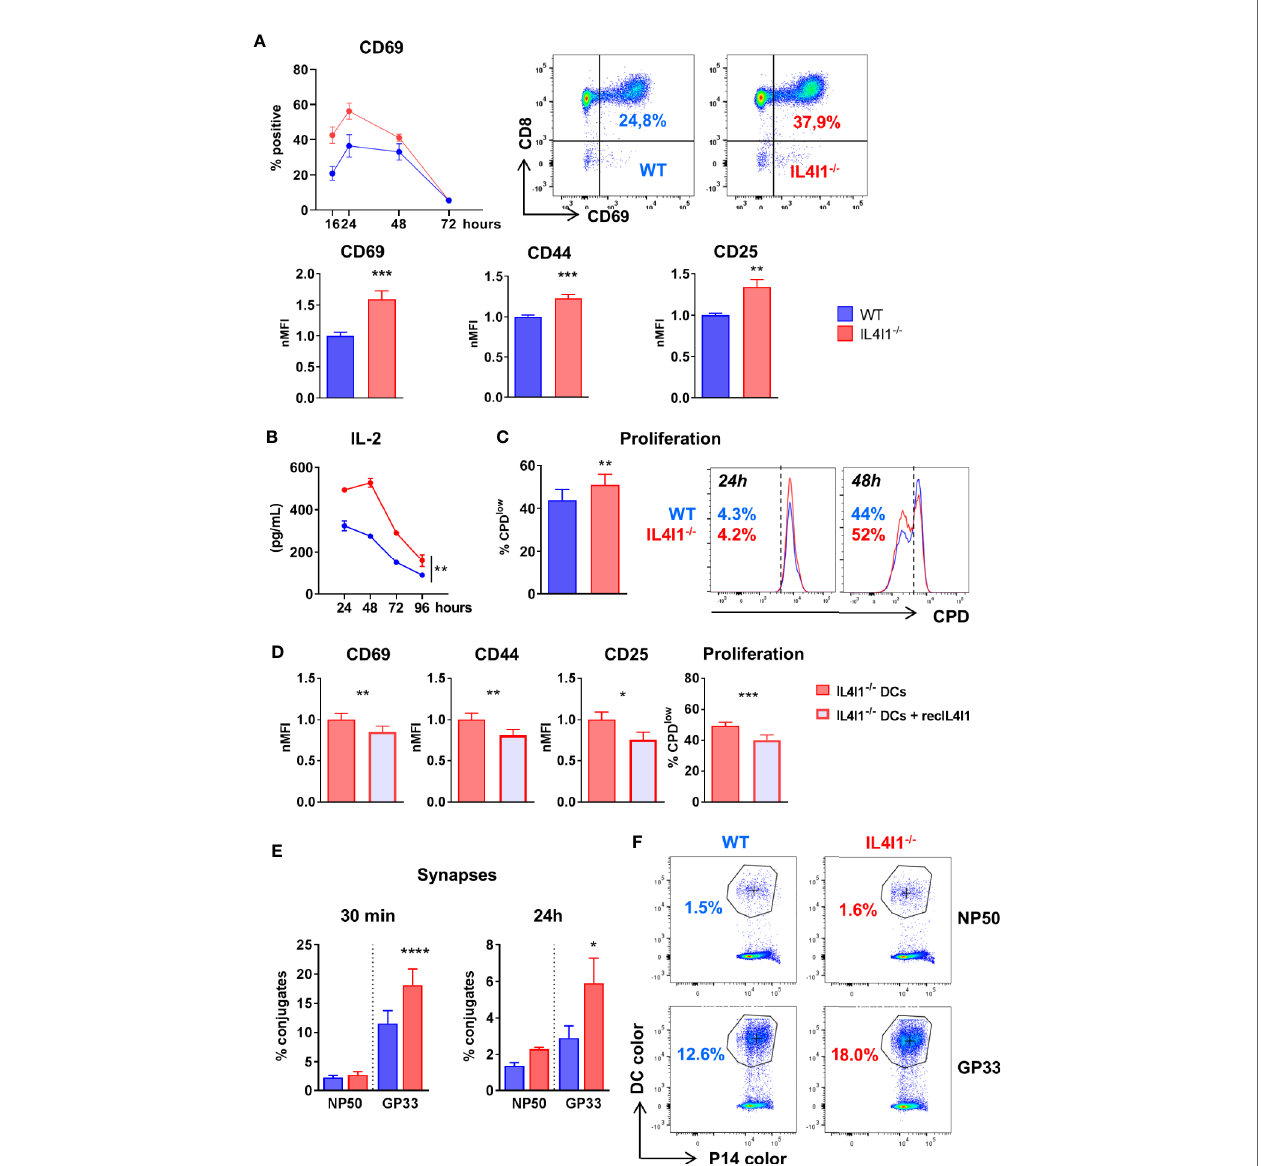
FIGURE 5 | Stronger in vitro activation of P14 cells by IL4I1 -/- DCs. DCs from WT (blue) and IL4I1 -/- (red) mice were sorted negatively, pulsed with the GP33 peptide, and plated with sorted P14 CD8 + T cells at a 1:10 ratio. (A) Expression of surface activation markers measured by fl ow cytometry on P14 cells. Top graph and dot-plots: kinetics of CD69 + P14 cells (left; mean ± SEM from one representative experiment, with two tests per condition using DCs sorted from independent mice) and representative data at 16 h (middle and right). Bottom histograms: the MFI of CD69, CD44, and CD25 at 24 h was normalized to the mean results in cocultures with WT DCs (nMFI). Mean ± SEM of values from a minimum of 12 tests per condition obtained in six to eight independent experiments. ** p < 0.005, *** p < 0.001 (Paired t-test). (B) Kinetics of IL-2 production in the cocultures from one representative experiment (n = 2 tests per condition). ** p < 0.005 (two-way ANOVA). (C) Proliferating fraction of P14 cells at 48 h measured by fl ow cytometry using cell proliferation dye (CPD). Mean ± SEM from four experiments in duplicate (left) and representative data of a proliferation assay at 24 and 48 h (right). (D) Activation and proliferation of P14 cells measured as in A and C after coculture with IL4I1 -/- DCs in the presence or absence of recombinant murine IL4I1 (recIL4I1). Mean ± SEM of eight tests from four independent experiments. * p < 0.05 ** p < 0.005, *** p < 0.001 (Paired t-test). (E) DCs and P14 cells were stained with different cell dyes. The percentage of P14 cells forming conjugates with DCs pulsed with GP33 or the control NP50 peptide were measured by fl ow cytometry at 30 min and 24 h after starting the coculture. Mean ± SEM of nine and three independent experiments at 30 min and 24 h, respectively, with one to three tests per condition. * p < 0.05, **** p < 0.0001 (Paired t-test). (F) Representative analysis of P14 conjugates at 30 min. Left: WT DCs, right: IL4I1 -/- DCs. The circled “ bicolor ” population corresponds to